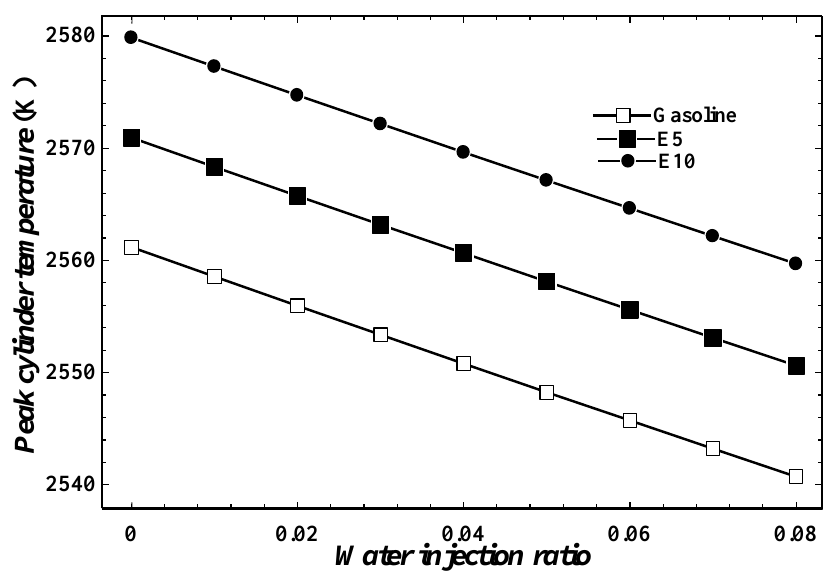
Figure 11. Peak cylinder temperature in various water injection ratios for each fuel.